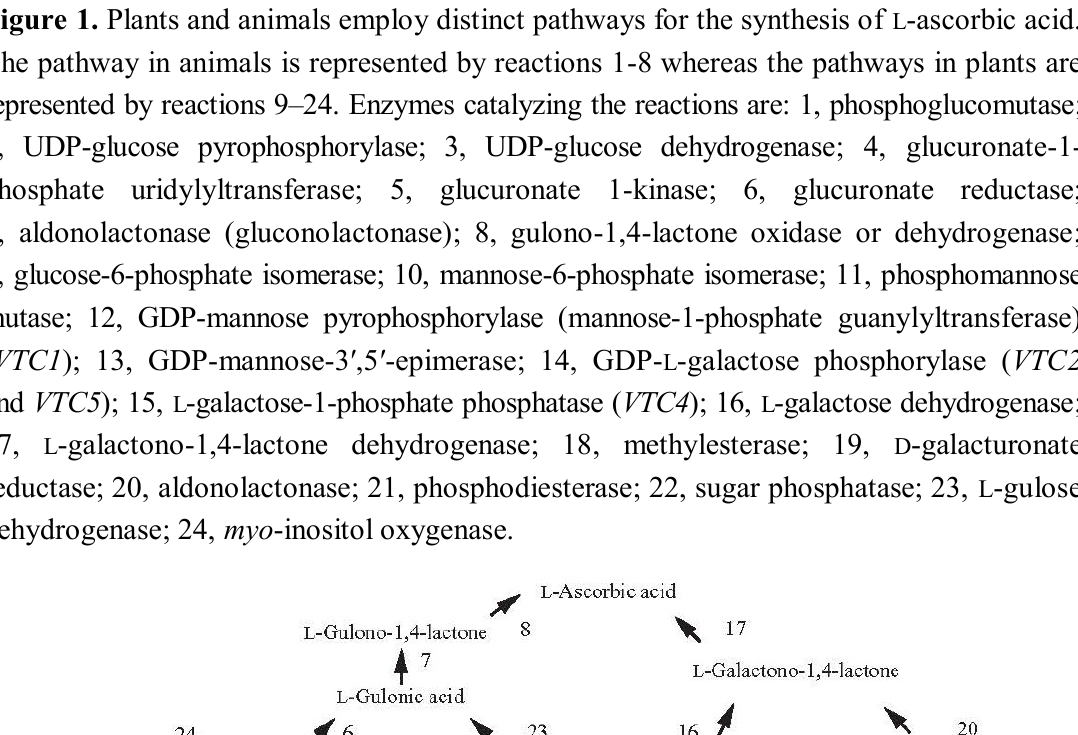
Figure 1. Plants and animals employ distinct pathways for the synthesis of L -ascorbic